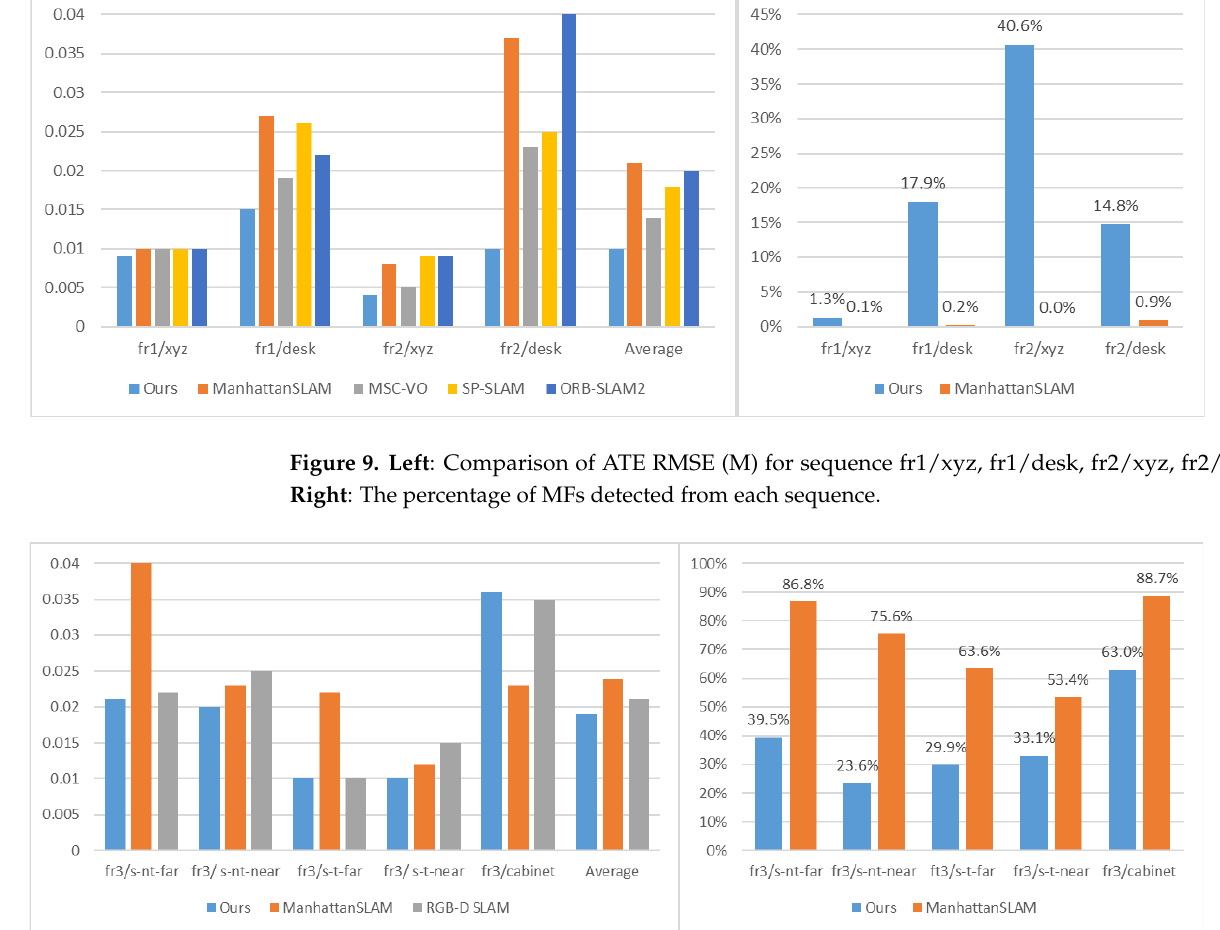
Figure 8. Left : Local map for the fr3-longoffice sequence. Right : Estimated trajectories with our method (blue) and ManhattanSLAM (green), and the ground truth (dashed grey) in TUM RGB-D dataset fr3-longoffice sequence.